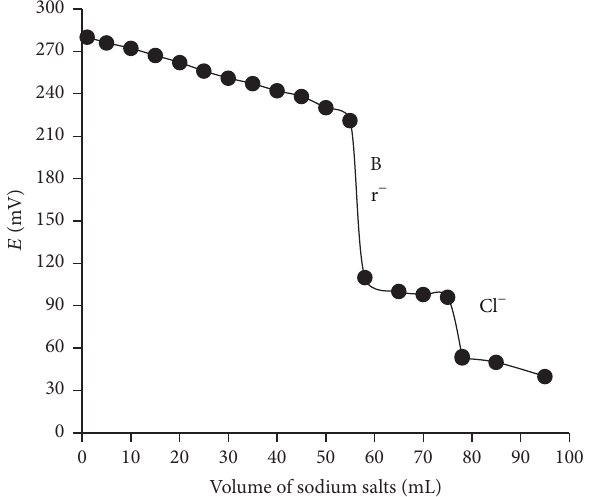
Figure 5: Titration curve of 10mL (0.01M) TlNO 3 with 0.003 M NaBr and 0.1M NaCl solutions.